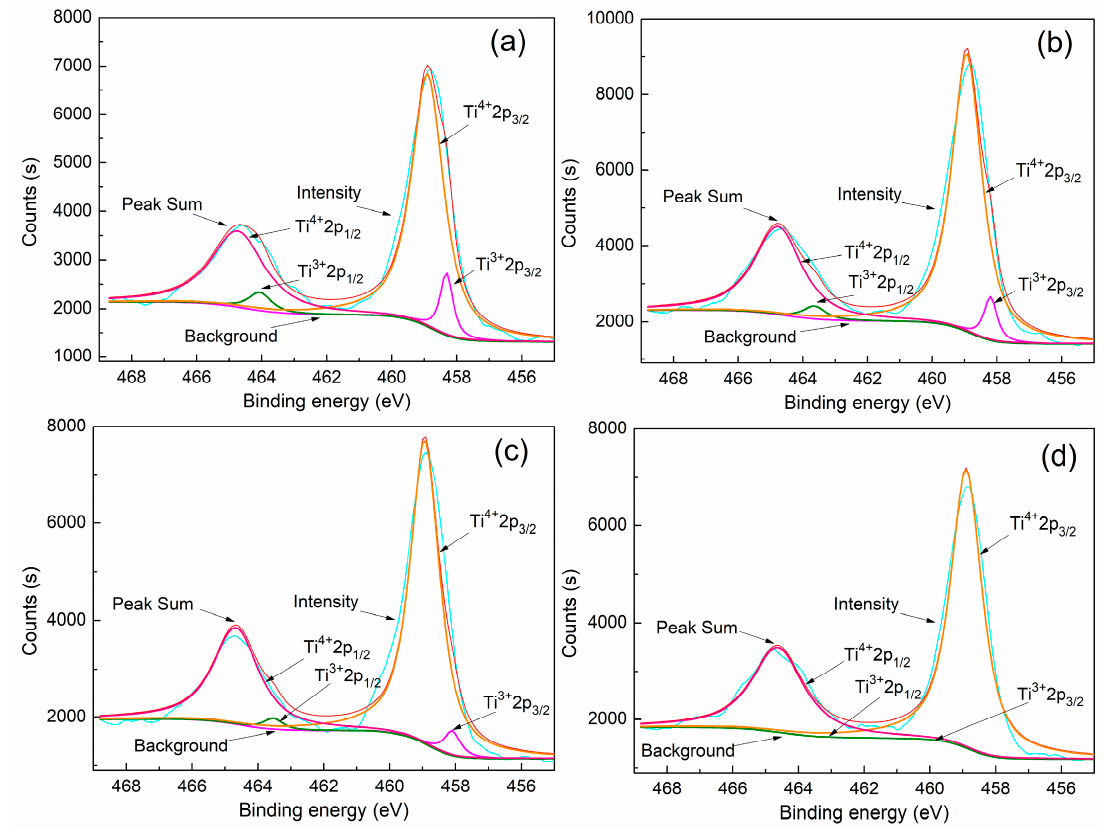
Figure 7. XPS patterns of detail scan of Ti in the modified titanium slag: ( a ) 0% B 2 O 3 , ( b ) 2% B 2 O 3 , ( c ) 4% B 2 O 3 , and ( d ) 6% B 2 O 3 . Table 2. XPS results of modified titanium slag with different additive (B 2 O 3 ) amounts.